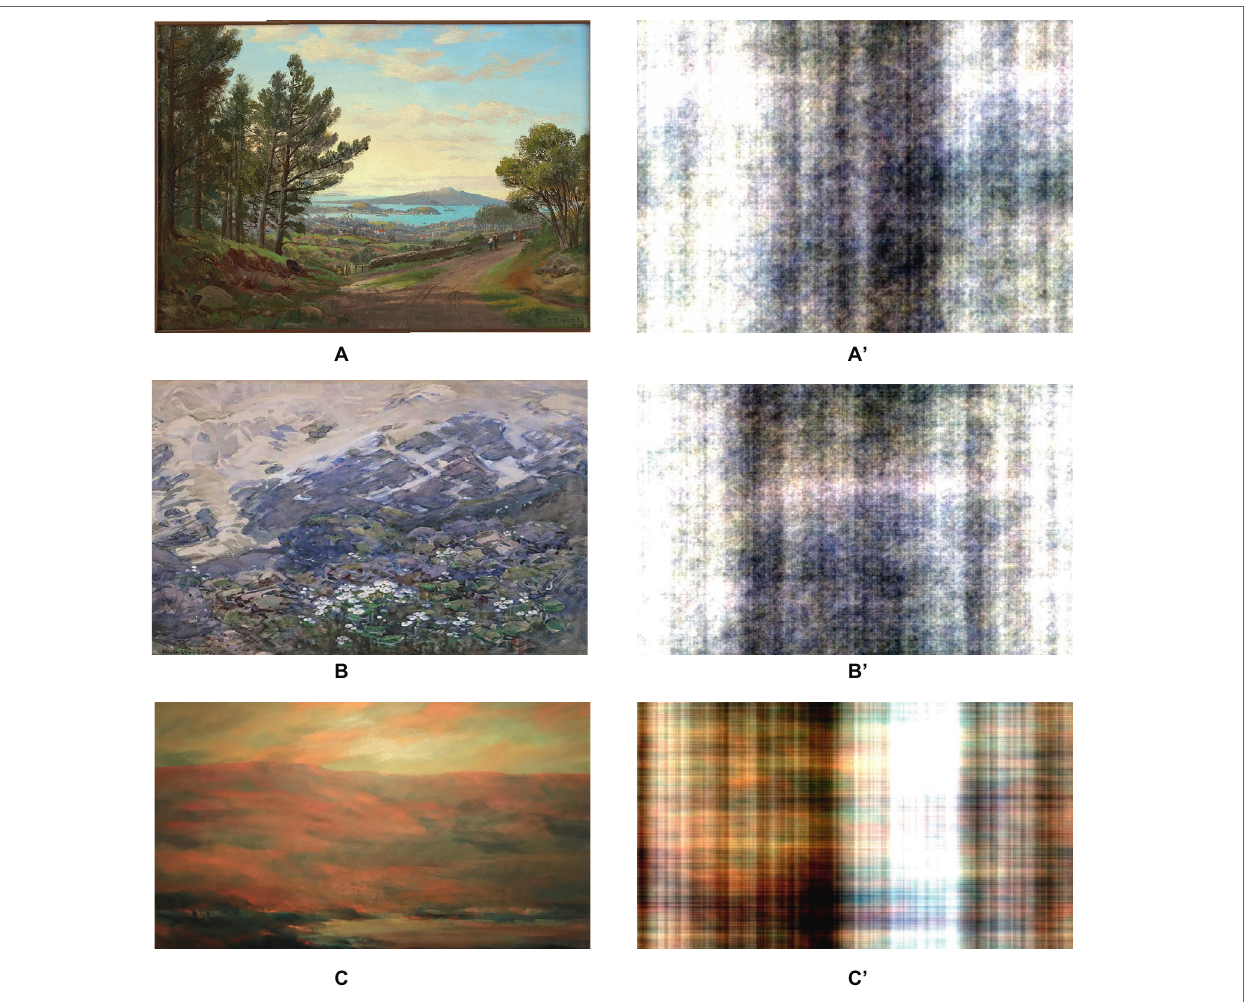
FIGURE 2 | Examples of the landscape artworks (A – C) and their scrambled versions (A ′ – C ′ ) . (A) is a painting by Charles Blomfield, Auckland Harbour from Mt Eden, which is in the public domain. (B) is by Margaret Stoddart, Mountain Lilies, reprinted with permission by the Christchurch Art Gallery Trust Collection. (C) is by Elizabeth Rees, Cove, reprinted with permission provided by Elizabeth